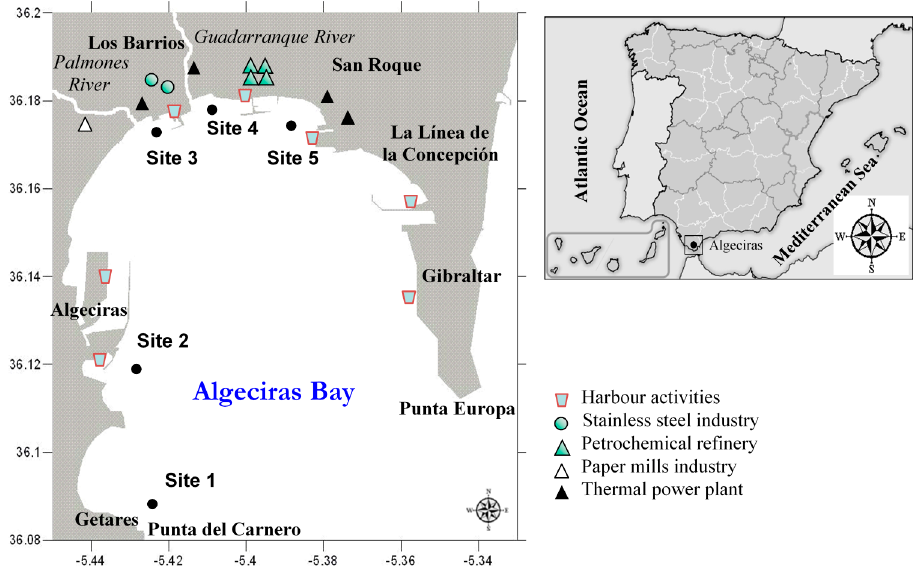
Figure 1. Map of Algeciras Bay showing the sampling sites and the principal anthropogenic activities of the area.